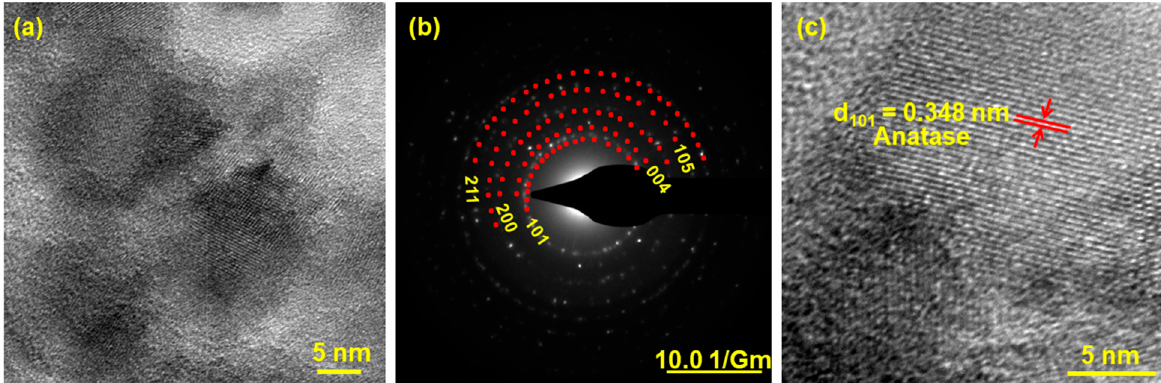
Figure 2. ( a ) High magnification TEM image, ( b ) HRTEM image, and ( c ) SAED pattern of TiO 2 -Mo-3.1.